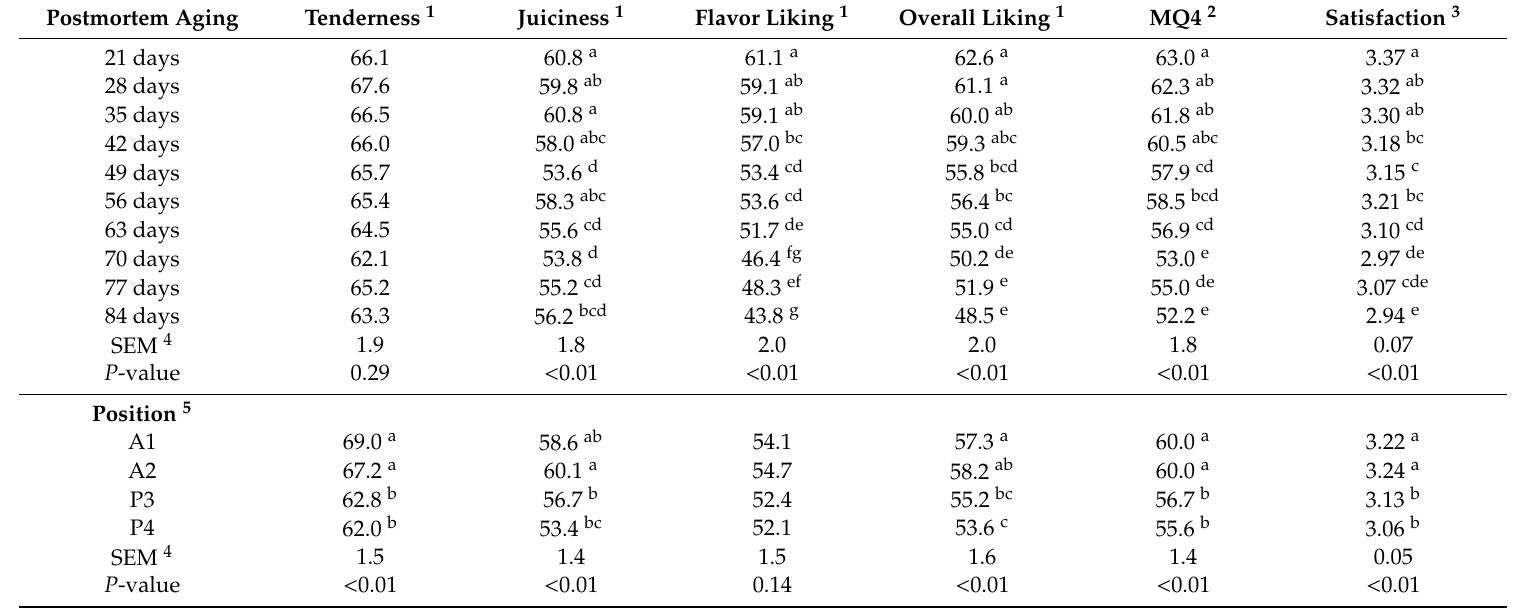
Table 3. The E ff ects of postmortem aging and position within the longissimus lumborum on eating quality scores as rated by consumers ( n = 1080). Postmortem